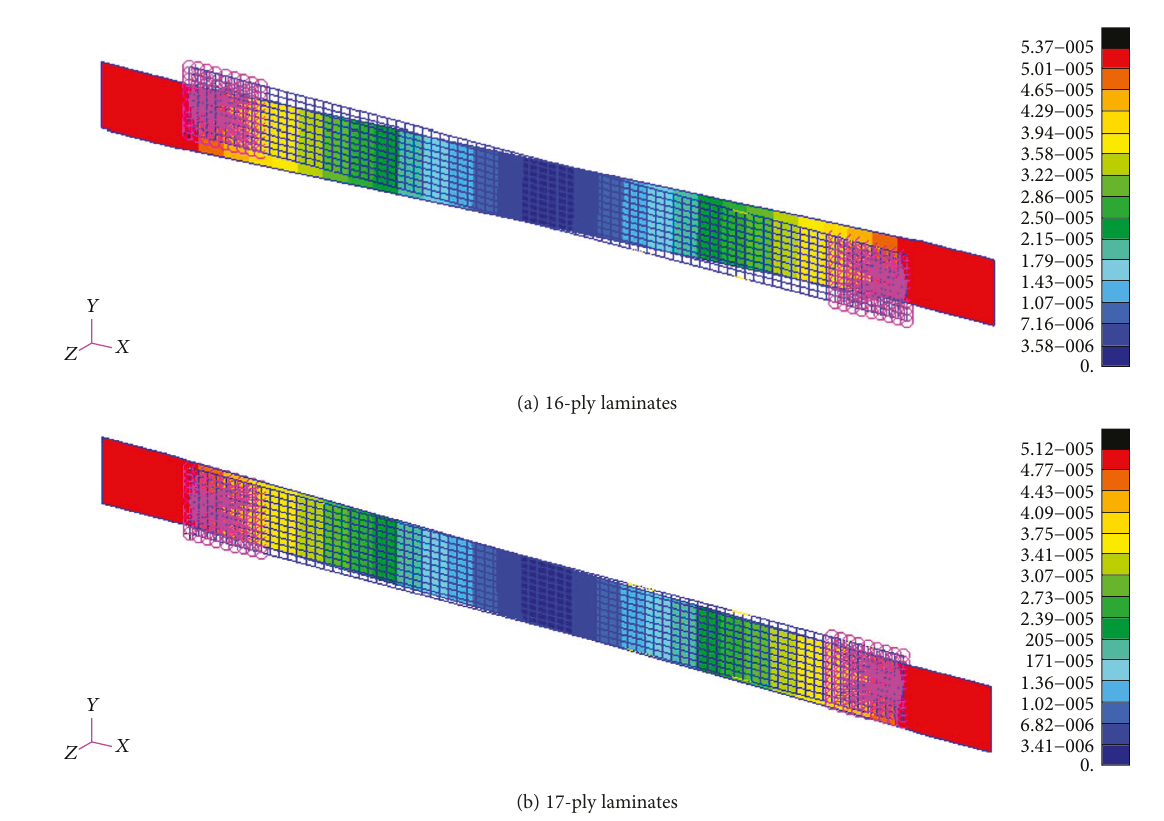
B D F 0 S laminates due to extension load.